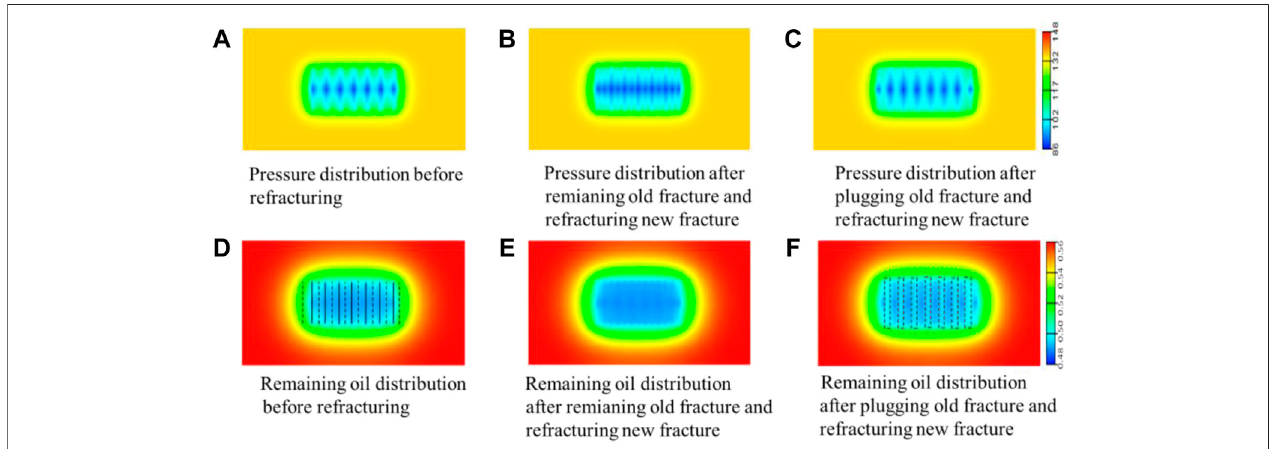
FIGURE 14 | Distribution diagram of pressure and remaining oil under different refracturing modes. (A) Pressure distribution refracturing before (B) Pressure distributionafterremaininggoldfractureand refracturingnewfracture (C) Pressure distribution after pluggingoldfractureandrefracturingnewfracture (D) Remainingoil